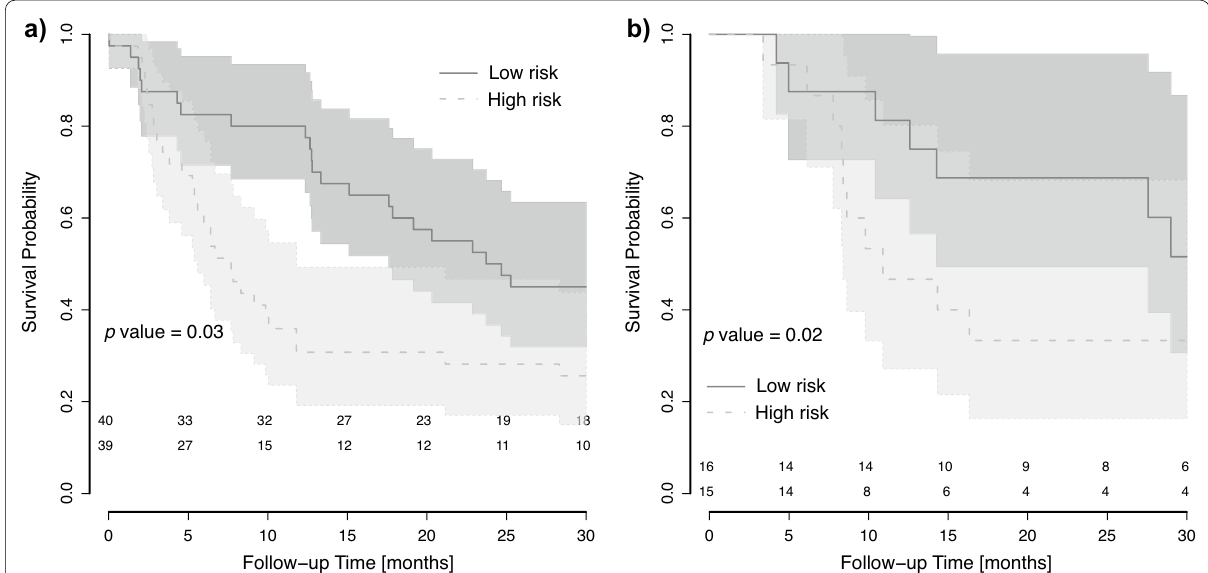
Fig. 5 Patient stratification based on 12‑month EFS. Patient stratification into high risk (light grey, interrupted lines, 95%‑CI in light grey) and low risk (dark grey, solid lines, 95%‑CI in dark grey) was significant for 12‑month EFS: a training cohort, p value